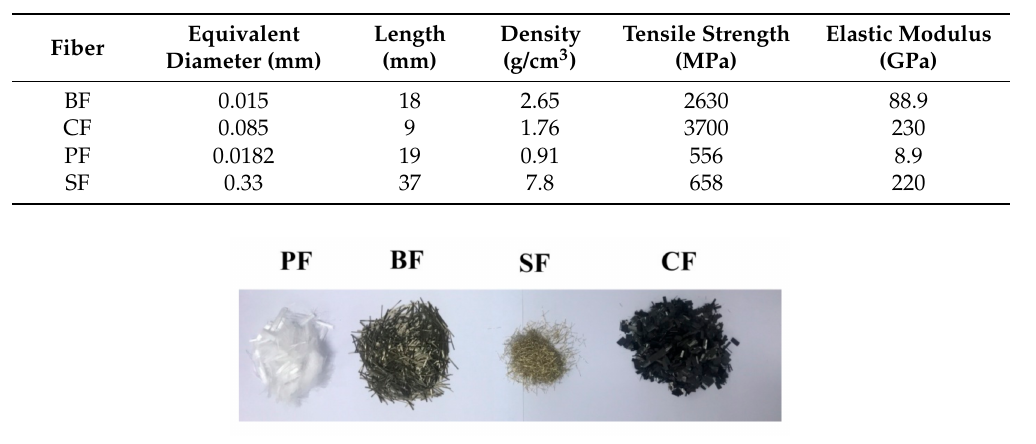
Table 2. Physical and mechanical properties of fibers.